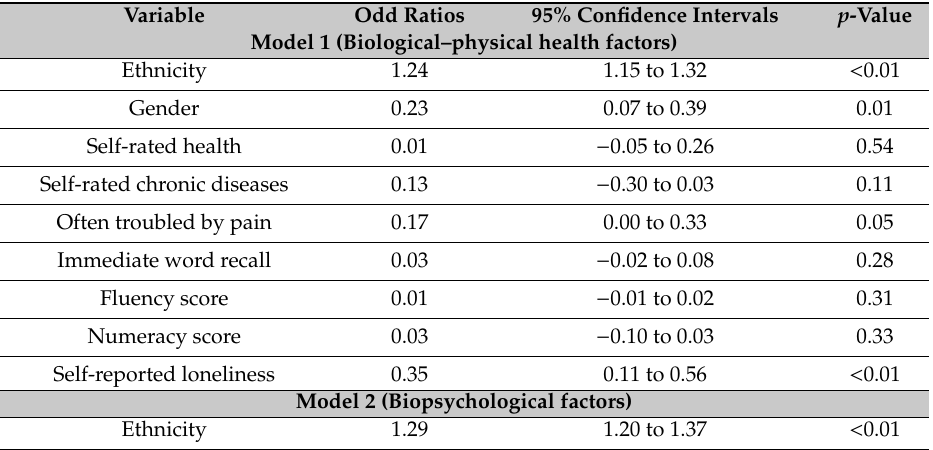
Table 2. Summary of the cross-sectional caregiver versus non-caregiver multivariate analysis results.